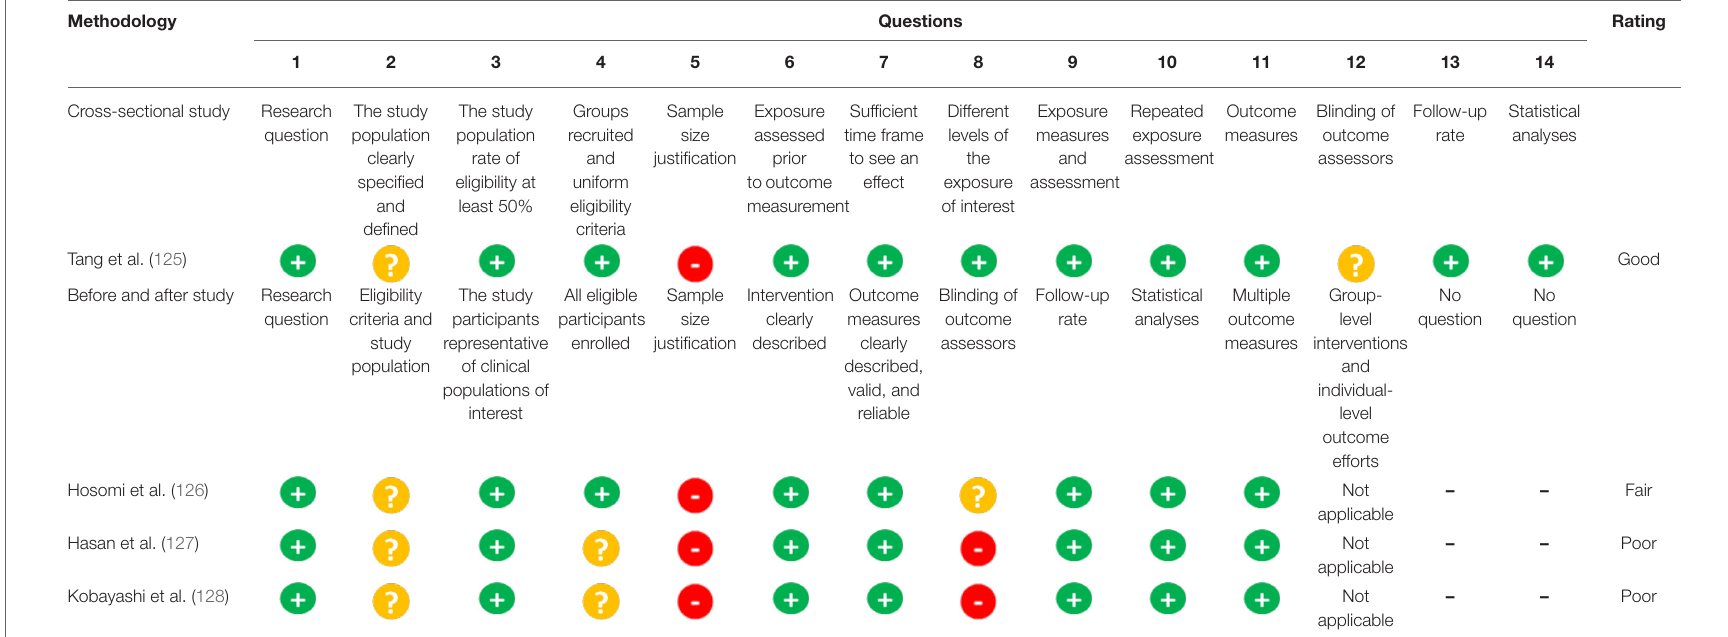
TABLE 4 | Assessment of risk of bias of the reviewed studies ( n =